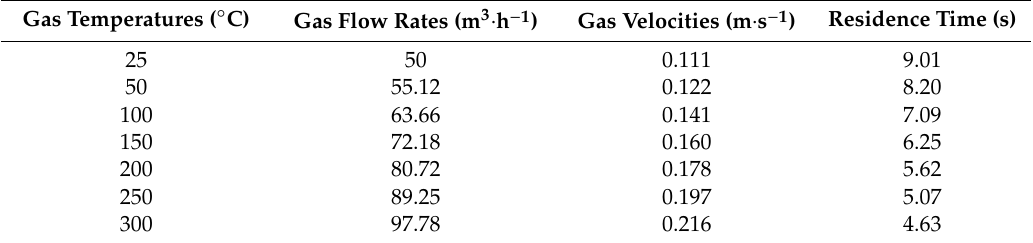
Table 1. Gas flow rates and residence time of simulated flue gas in reaction tower under various inlet temperatures measured at sampling point